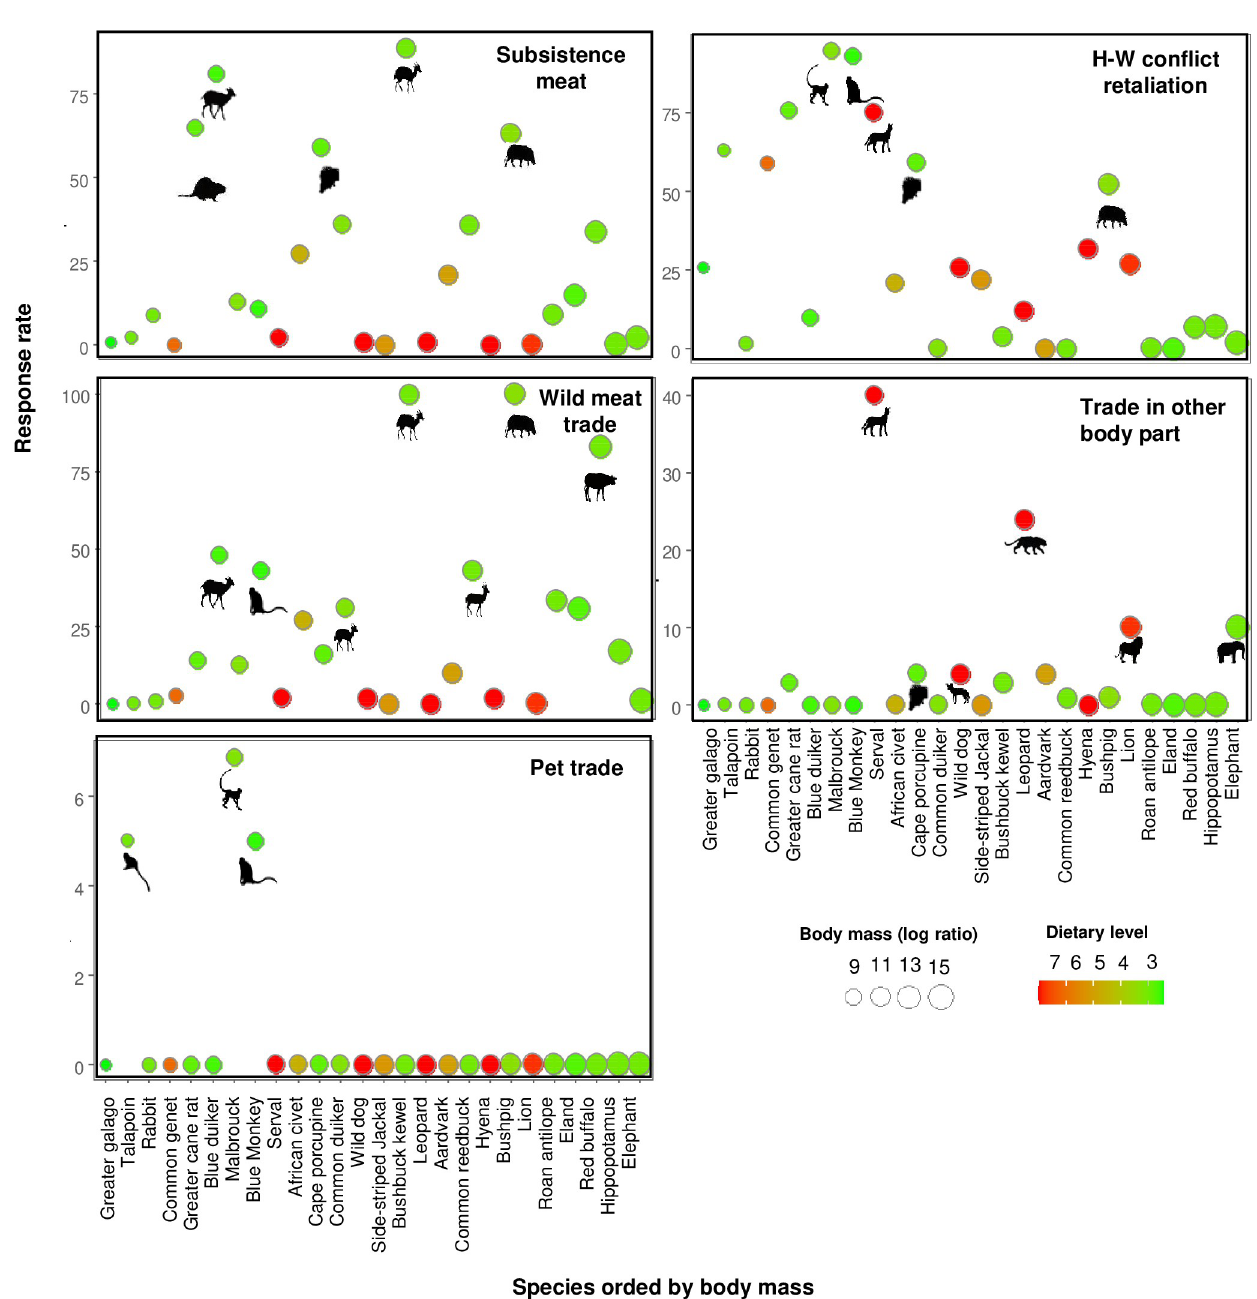
Fig 4. Species selected to meet different types of hunting motivations. Response rates were calculate from all interviewed hunters (n = 115). Species are denoted by their English names and ordered left to right from smallest to largest. Circle sizes are proportional to species body mass; circle colours denote trophic level in terms of dietary energy, ranging from green (lowest) to red